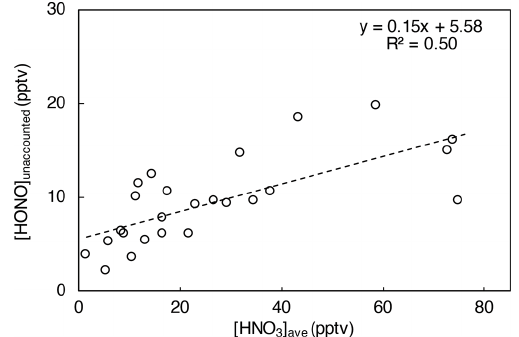
Figure 8. HONO concentration unaccounted for by NO x -related processes and pNO 3 photolysis ( [ HONO ] unaccounted , in pptv, aver- aged for each day from 10:00 to 15:00) plotted against HNO 3 con- centration averaged for 24h prior to local noontime ( [ HNO 3 ] ave , in pptv) in island-influenced air with [NO 2 ] <